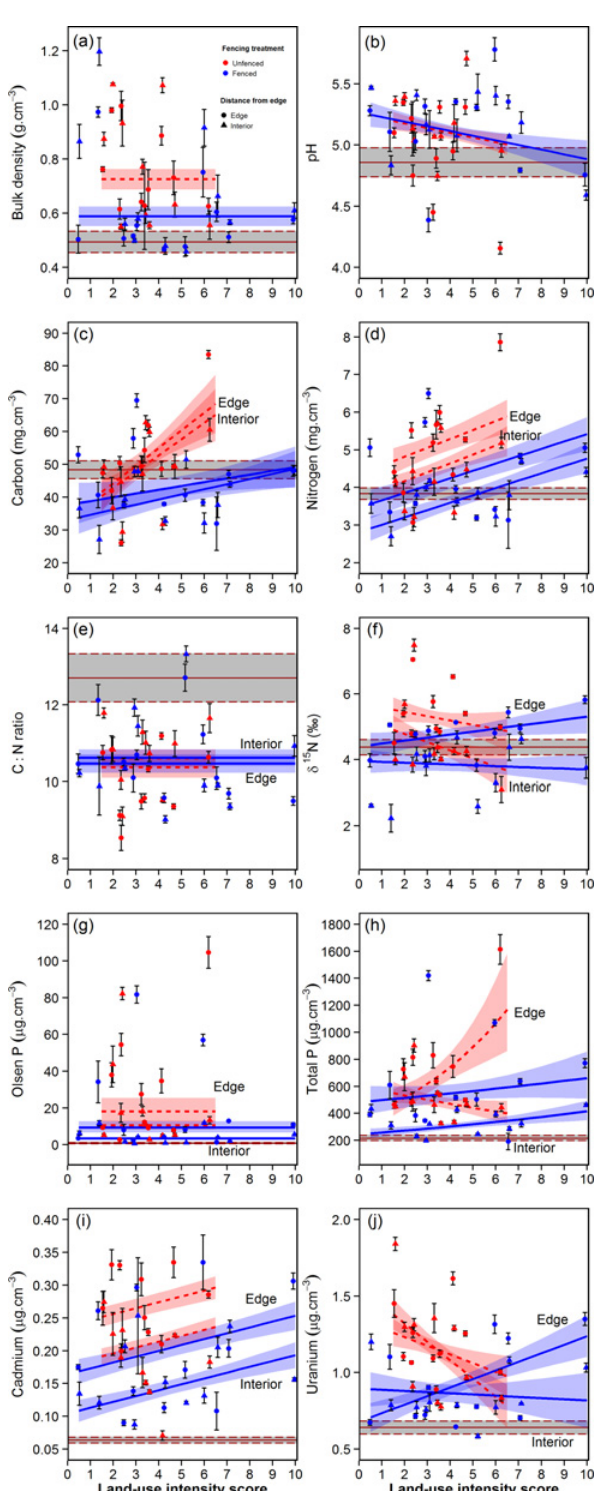
Figure 4. Predicted relationships between surrounding agricultural land-use intensity and soil biogeochemistry within fenced and unfenced forest remnants. The mean ( ± 1 S.E.) fitted relationships were derived from the final model-averaged solution (Table 2) using the ‘ lmePredict ’ function, while holding other fixed effects constant at their mean values. Symbols represent the raw means ( ± 1 S.E.), corrected